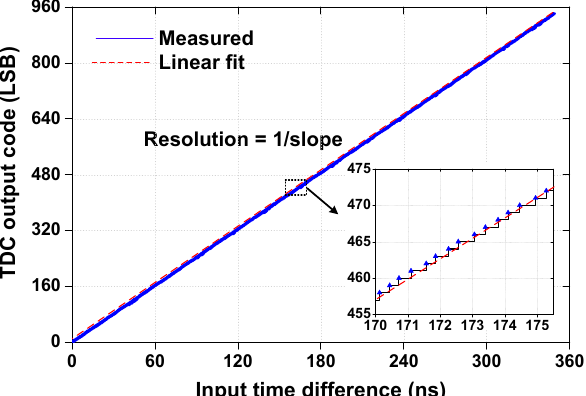
Figure 16. Measured transfer characteristic of the TDC.